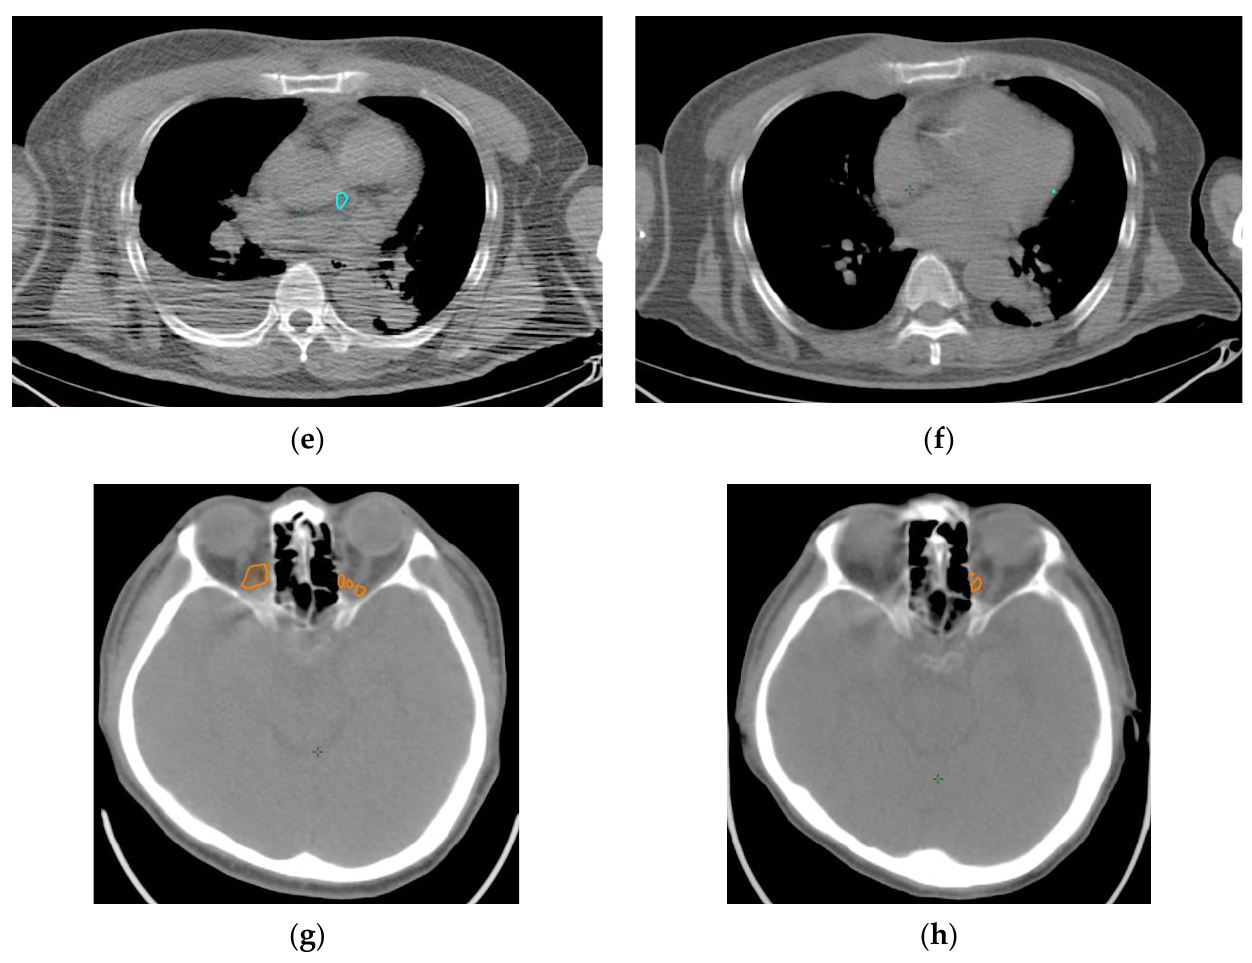
Figure 1. Pre- and post-treatment SUV-H EAT and SUV-H OAT for patients with different treatment responses, demonstrated by PET/CT viewer. ( a ) Pre-treatment and ( b ) post-treatment SUV-H EAT are shown in blue for a patient with CR. ( c ) Pre-treatment and ( d ) post-treatment SUV-H OAT are presented in orange for the same patient with CR. ( e ) Pre-treatment and ( f ) post-treatment SUV-H EAT are shown in blue for a patient with PD. ( g ) Pre-treatment and ( h ) post-treatment SUV-H OAT are presented in orange for the same patient with PD. SUV-H EAT, high standardized uptake value epicardial adipose tissue; SUV-H OAT, high standardized uptake value orbital adipose tissue; PET/CT, positron emission tomography/computed tomography; CR, complete response; PD, progressive disease.